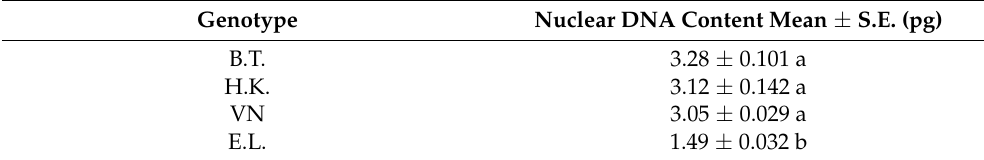
Table 7. Mean comparison of different P. vulgaris L. studied